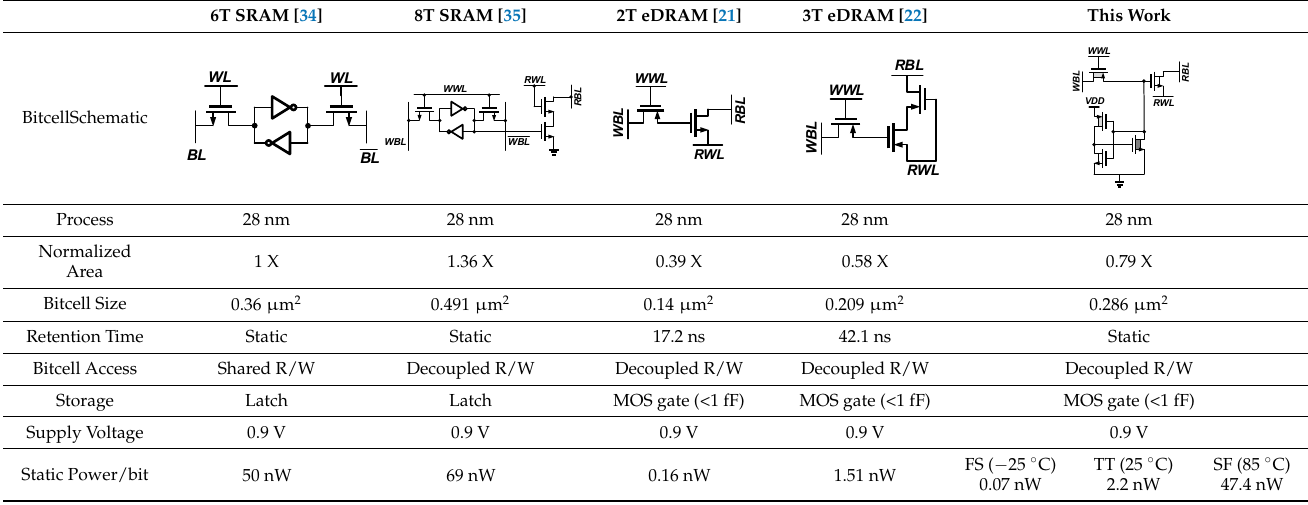
Table 3. Comparison of memory cells implemented in the 28 nm process.